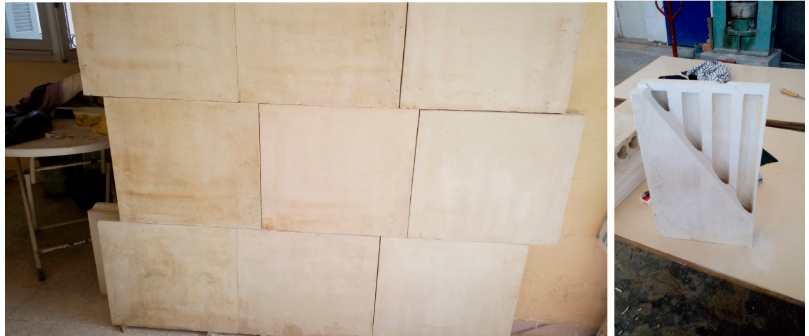
Figure 16. Flatness of the new gypsum plaster